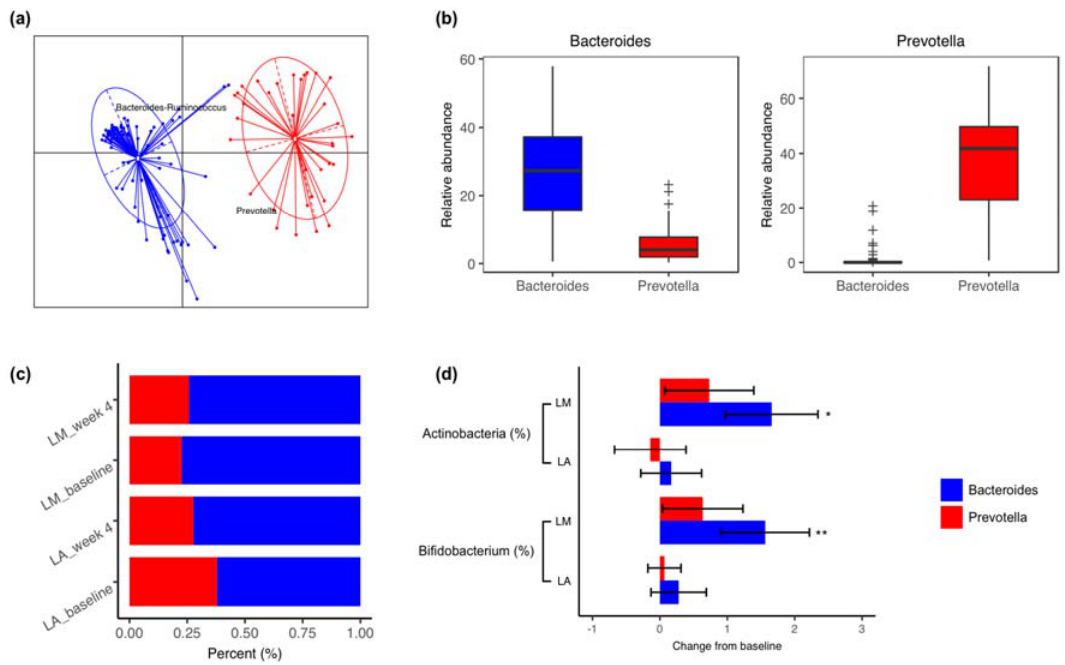
Figure 3. Enterotypes stratification and changes in gut microbiota and clinical variables by enterotypes. ( a ) The first two principal coordinates of Jensen-Shannon distances based on the relative abundance profiles at the genus level. ( b ) Relative abundance of bacterial taxa characteristic of each enterotype. Box represents the interquartile range, the line inside represents the median, whiskers represent 10–90 percentiles, “+” represents outliers that are past the ends of the whiskers. ( c ) Sample distribution over enterotypes before and after whole milk supplementation in lactose malabsorbers (LM) and absorbers (LA). ( d ) Comparisons of changes in the microbiota abundance in LM and LA with different enterotypes (LM with Bacteroides enterotype, n = 24; LA with Bacteroides enterotype, n = 18; LM with Prevotella enterotype, n = 7; LA with Prevotella enterotype, n = 11). Data are presented as Mean ± SEM (*, P < 0.05, and **, P < 0.01).